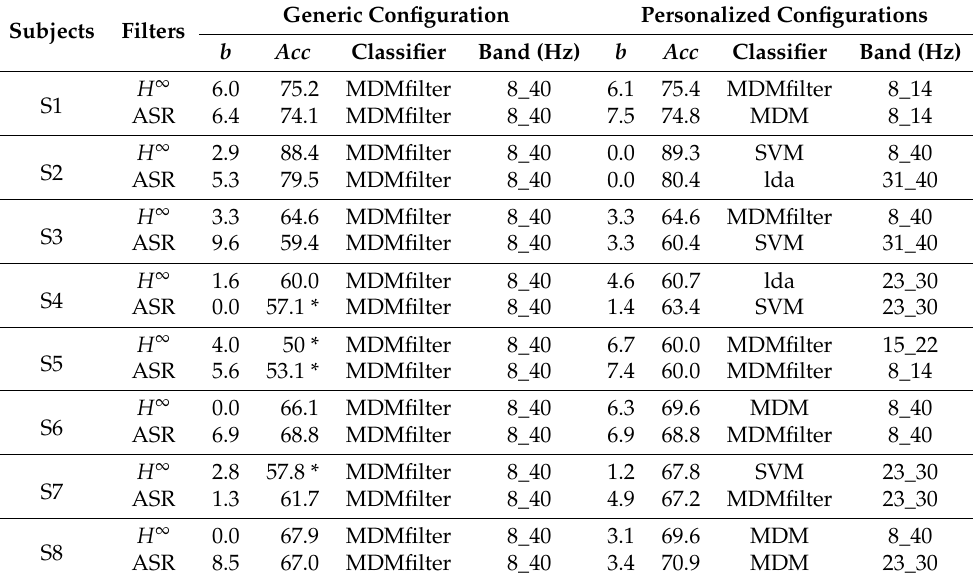
Table 4. Table with the configuration per subject, on the left the configuration selected from the previous table and on the right the best configuration per subject, specifying the filter and band in which it was produced. The solution is accompanied by an asterisk, if it did not pass the accuracy filter greater than randomness or